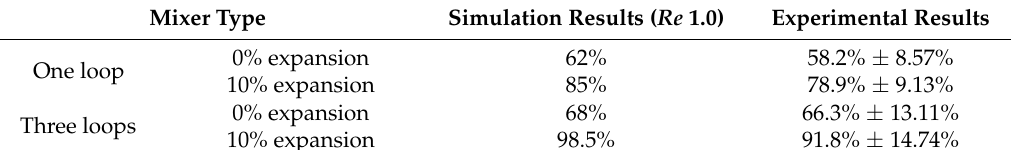
Table 8. Comparison of numerical and experimental mixer’s efficiency at Re 1.